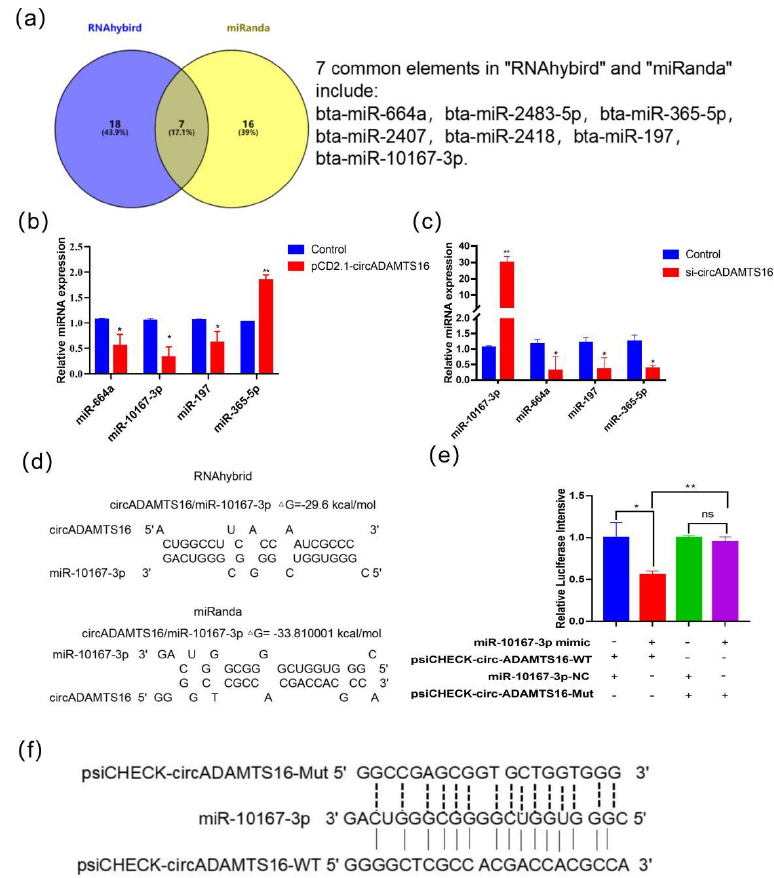
Figure 1. Identification of potential target miRNA of circADAMTS16. ( a ) RNAhybrid and miRanda predict potential miRNAs. ( b , c ) The expression of potential miRNAs was detected by qPCR. ( d ) RNAhybrid and miRanda online software were used to predict the targeted binding site of miR- 10167-3p and circADAMTS16. ( e ) circADAMTS16 and miR-10167-3p wild-type vector binding site and mutant type vector mutation site. ( f ) Dual luciferase reporting experiment verified the targeting relationship between miR-10167-3p and circADAMTS16. * p < 0.05, ** p < 0.01, ns indicated p > 0.05.